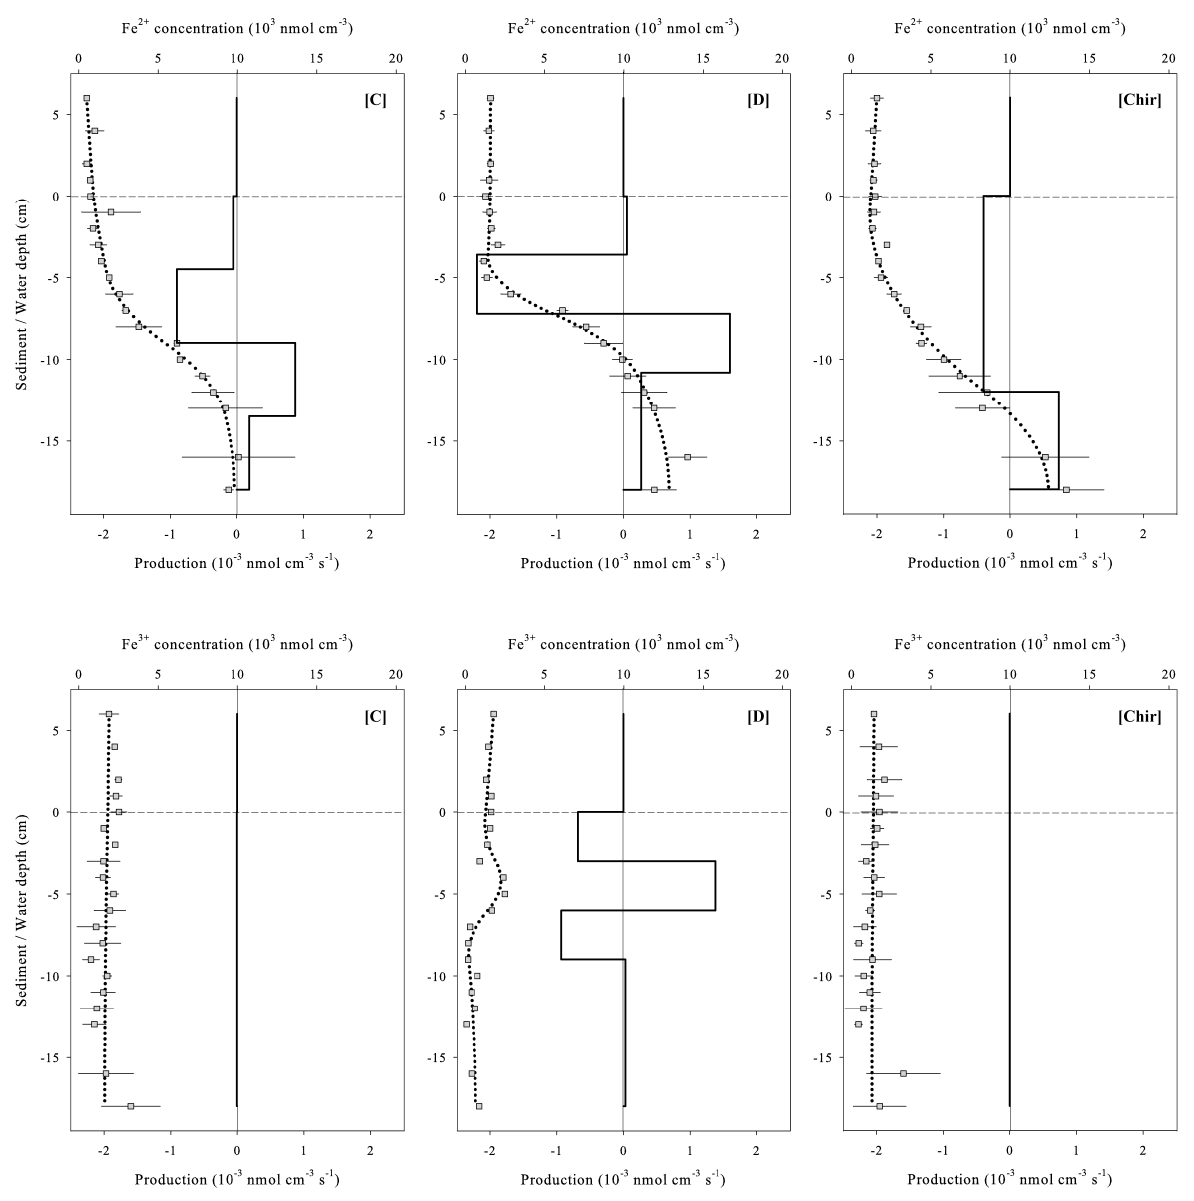
Fig. 4. Ferrous and ferric iron concentration profiles and production rates in the sediment estimated in the different treatments using the software PROFILE (Control: C, Defaunated: D, with chironomids: Chir). Grey dots are measured concentrations (Means ± SD, N = 4) and the dotted lines the fitted concentration profiles. The black lines show the production as a function of depth modelled from the concentration profiles. The horizontal dotted lines indicate the sediment-water